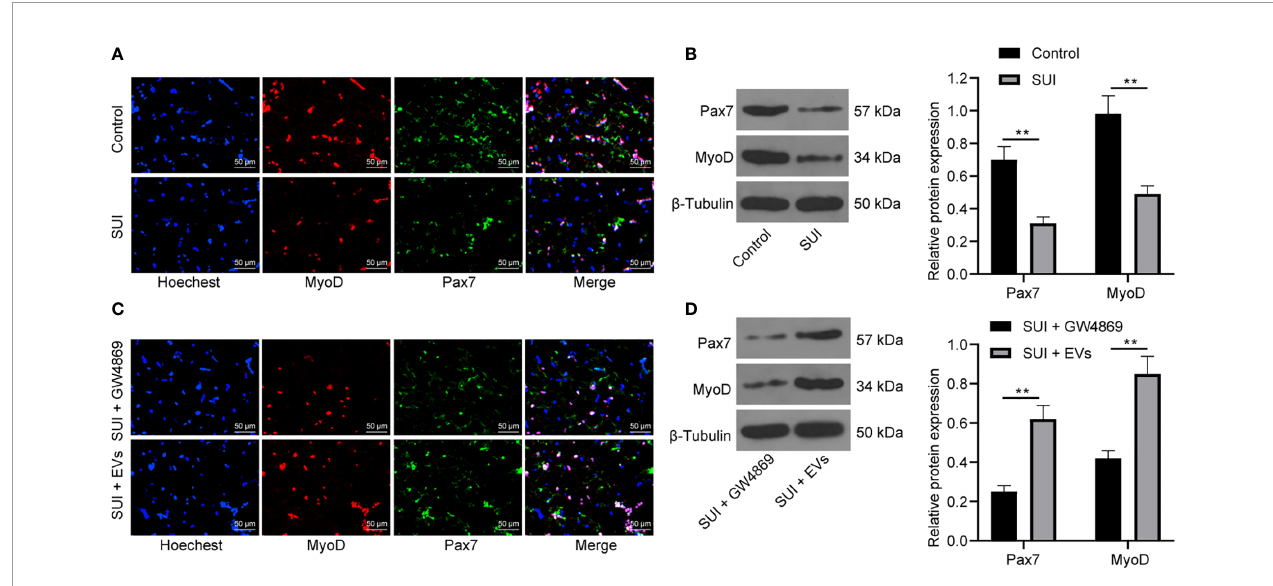
FIGURE 3 | Effects of ADSCs-EVs on activation of SUI primary SCs. (A, B) Immuno fl uorescence assay (A) and Western blot assay (B) were used to detect the in fl uence of Pax7 and MyoD protein expression in SUI primary SCs. (C, D) Immuno fl uorescence assay (C) and Western blot assay (D) were used to detect the effects of ADSCs-EVs on Pax7 and MyoD protein expression in SCs. The Western blot assay data was normalized to the background value and the control b -Tubulin band value. N = 3. The differences between two groups were analyzed by Student ’ s t − test (B, D) . ** P <